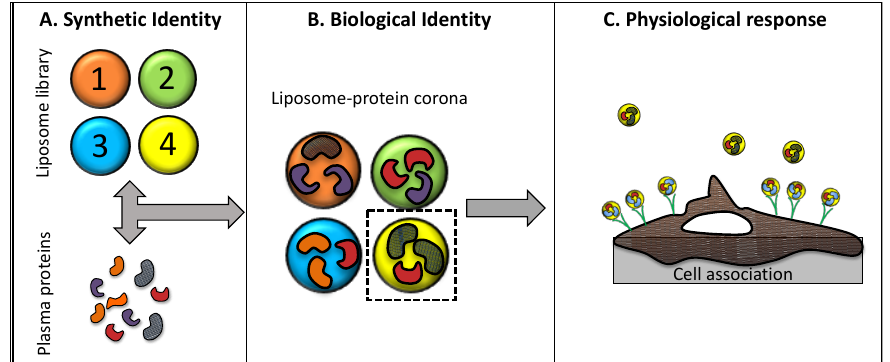
Figure 1. Schematic illustrating the protein corona fingerprinting strategy. ( A ) A library of liposomes is mixed with plasma proteins; ( B ) plasma proteins adsorb to the particle surface, forming liposome–protein complexes that are ranked for enrichment in protein corona ‘fingerprints’, i.e., plasma proteins that promote association with cancer cells; ( C ) selected formulations are incubated with cells in culture and cell association is measured by flow-assisted flow cytometry.